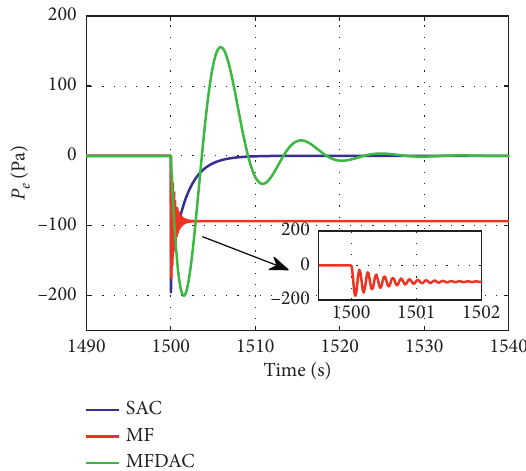
Figure 15: Pressure error of the sensor fault after reconfiguration.